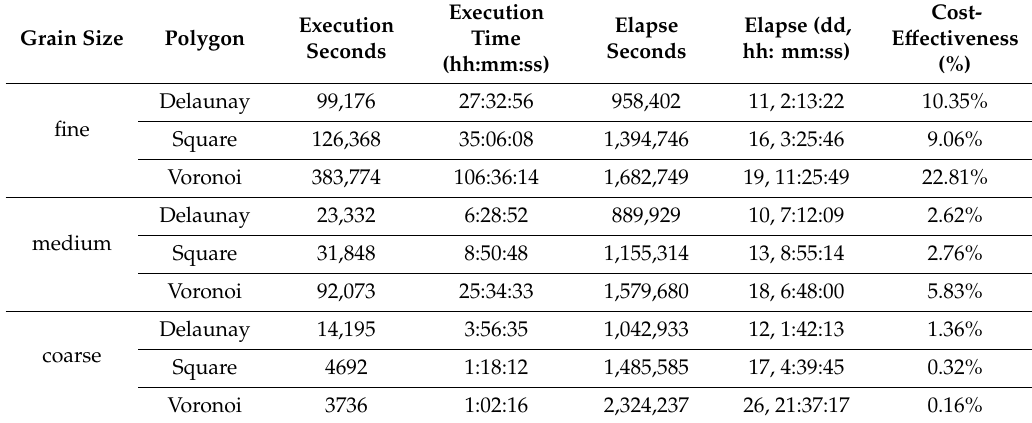
Table 13. Cost e ff